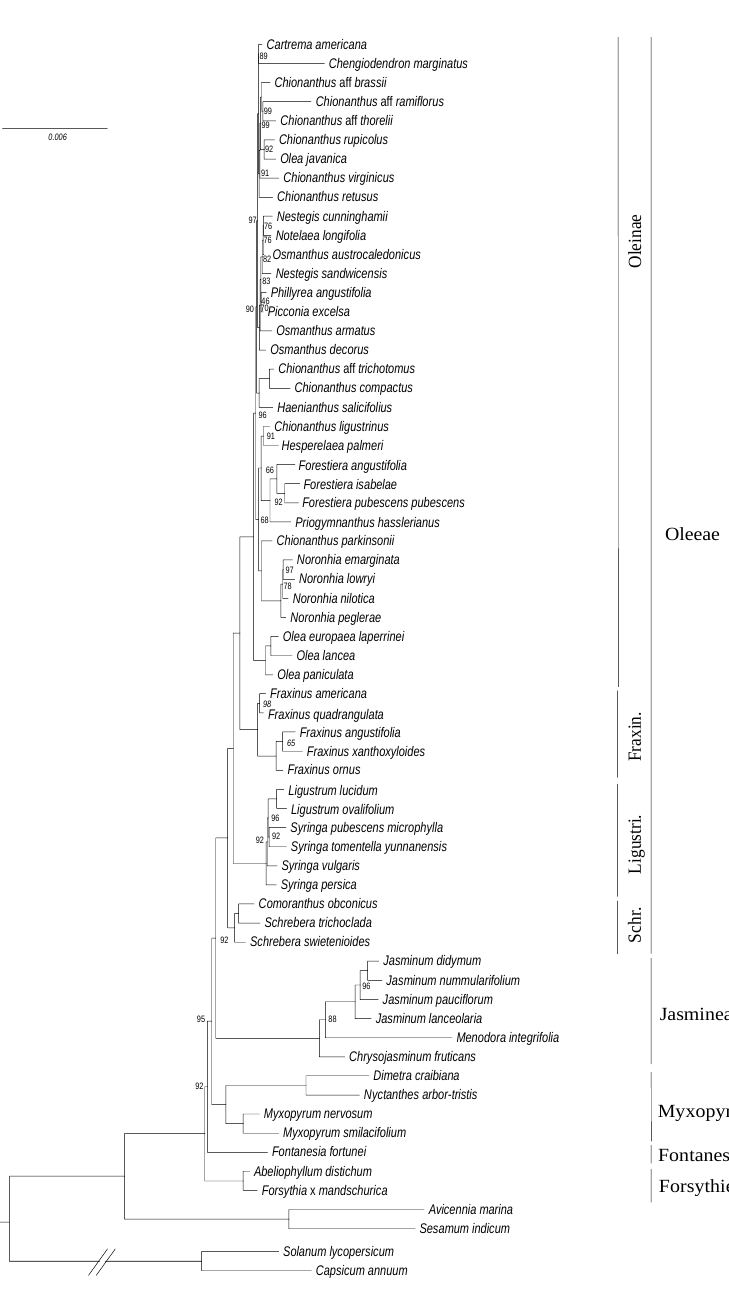
Figure 2. Maximum likelihood phylogenetic tree of Oleaceae based on the concatenation of 37 mitochondrial genes. The tree was rooted on the split with Solanaceae. The scale is in substitution per site. Ultrafast bootstrap support values are indicated on nodes when inferior to